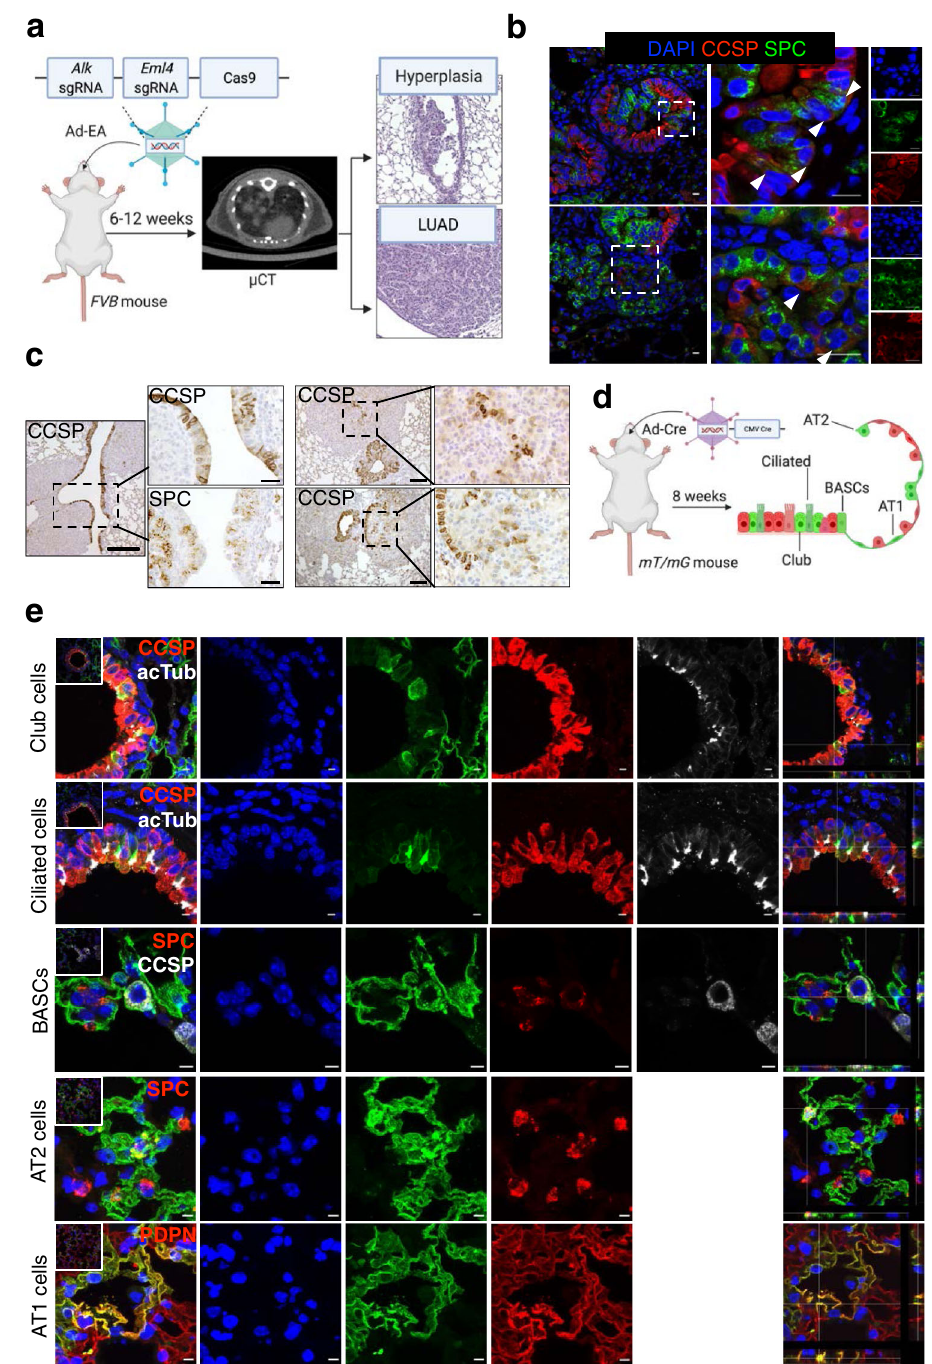
Fig.1| Mousemodeloflungadenocarcinomaandidenti fi cationofadenovirus- infected cell types. a Schematic of the Eml4-Alk mouse LUAD model used. Mice were intratracheally instilled with Ad-EA and μ CT was used to monitor tumour development. Representative H&E staining of an early lesion (hyperplasia) and a tumour are shown on the right. b Immuno fl uorescent staining of SPC (green) and CCSP (red) antibodies showing that Club cells in the bronchi start expressing SPC upon Eml4-Alk rearrangement. DAPI staining in blue. Original (left), magni fi ed overlay(middle),and theirsingle-channelimages(right)fromthe dashedareasare shown. Arrowheads show cells that are double-positive CCSP + SPC + . Scale bar: